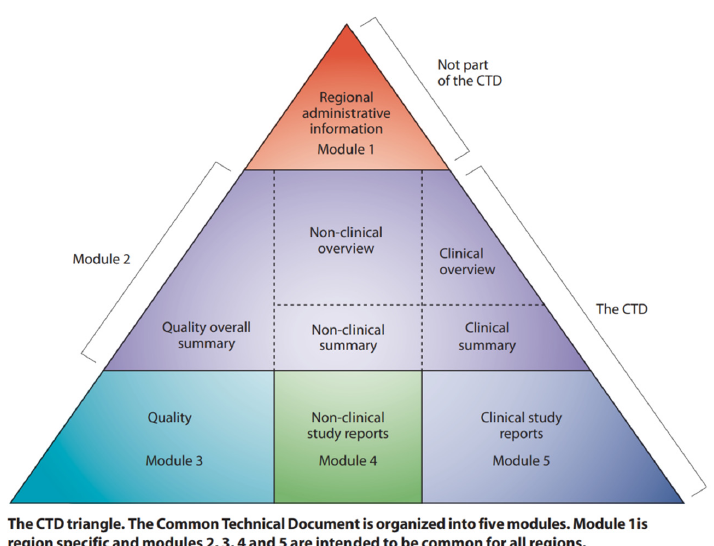
Figure 8. The Common Technical Document (Reference: [114]). The eCTD has five modules: 1. Administrative information and prescribing information. This is a country specific regional module, i.e., different for each region or country; 2. Common technical document summaries. This is a common module in all regions; 3. Quality; 4. Nonclinical study reports; 5. Clinical study reports. Image source: https://www.ich.org/page/ctd © International Council for Harmonisation of Tech-